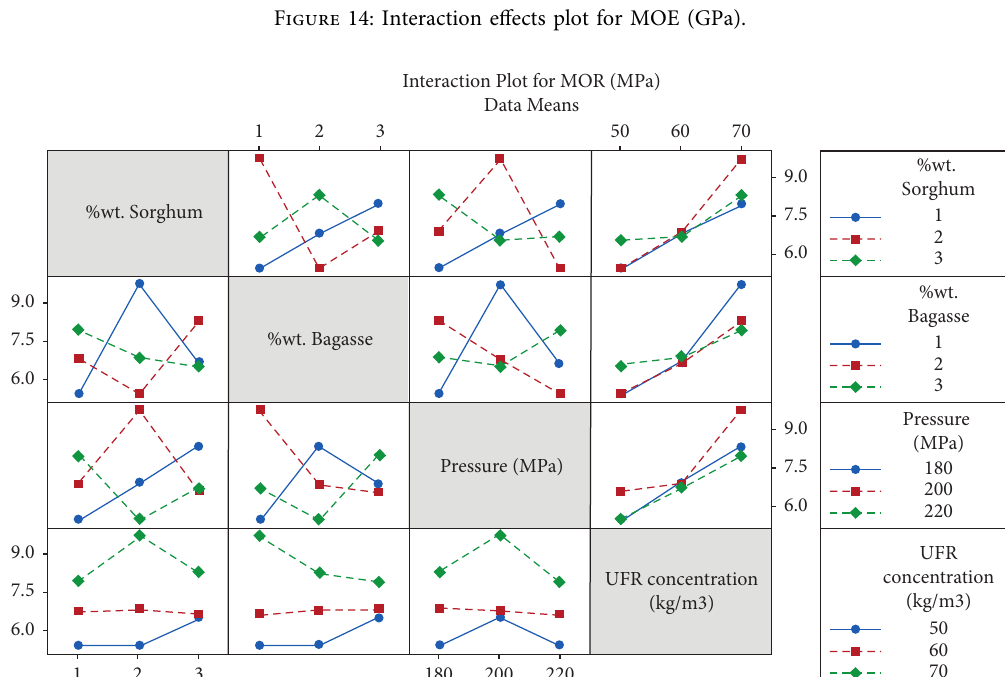
Figure 15: Interaction effects plot for MOR